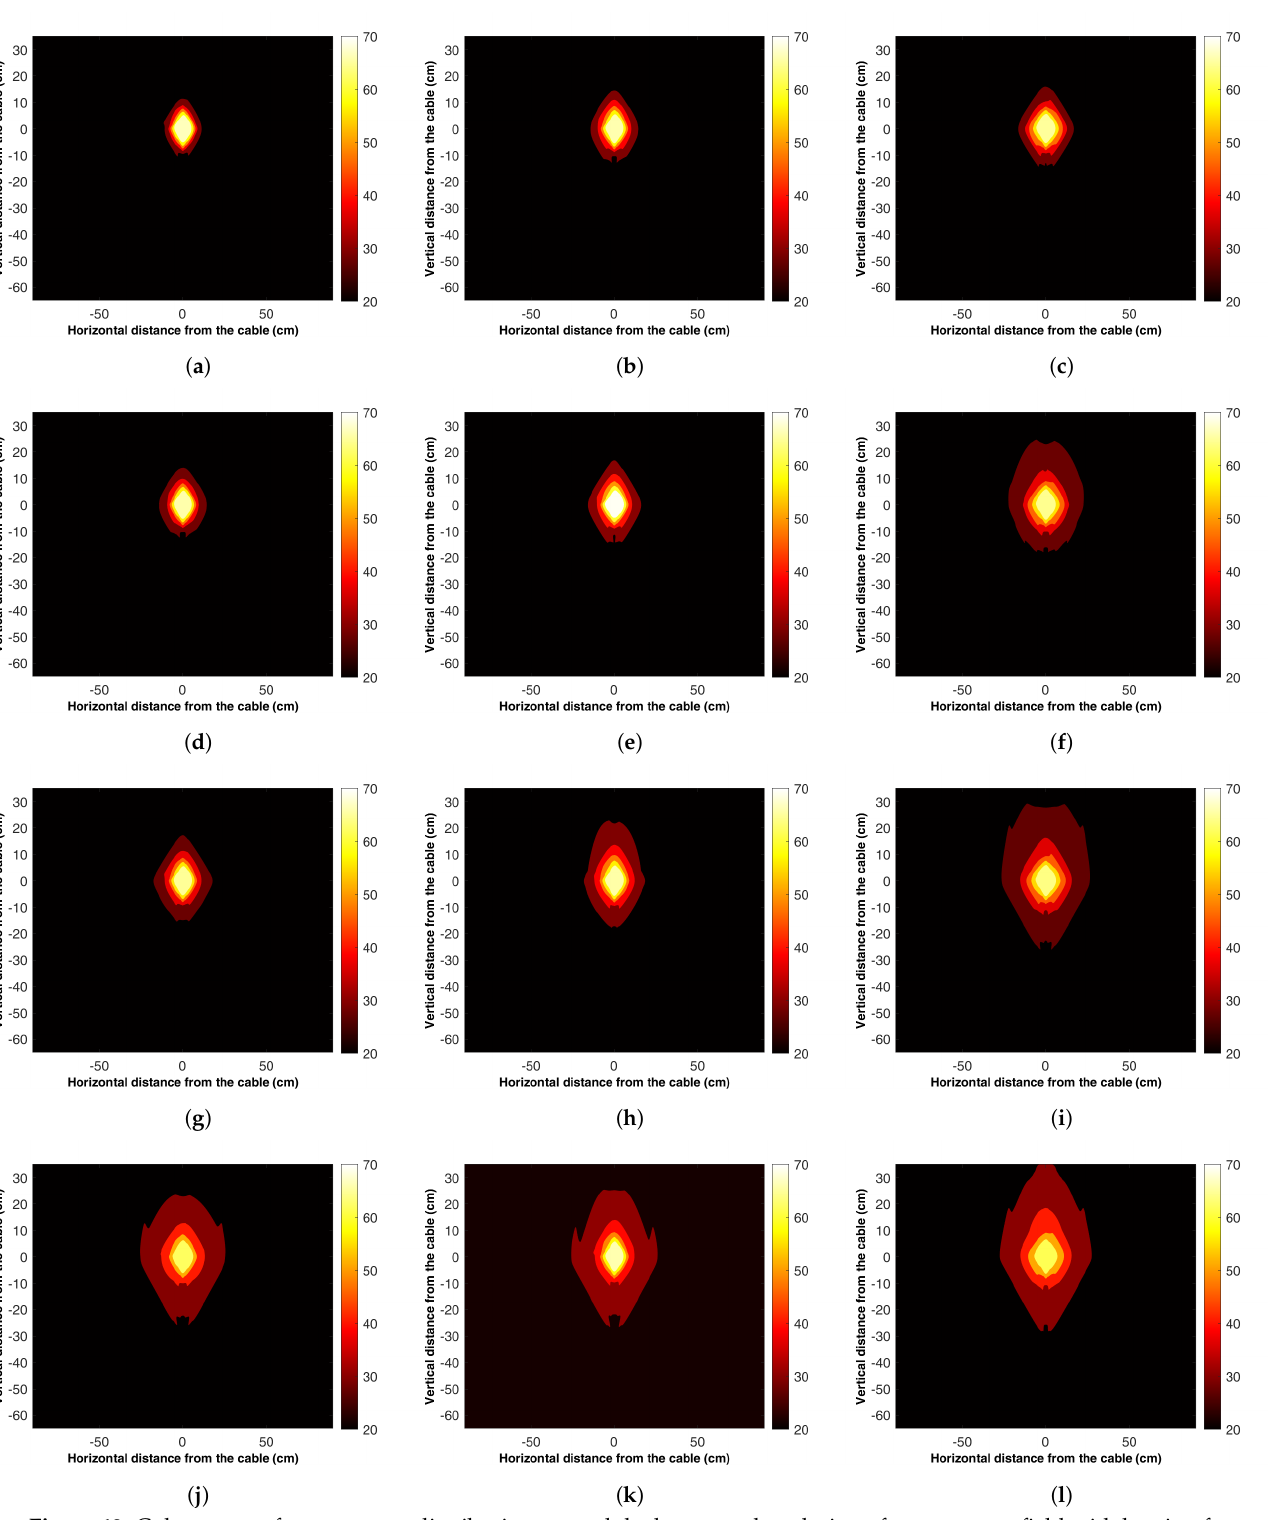
Figure 12. Colour map of temperature distribution around the heater and evolution of temperature field with heating for dry, unsaturated and saturated sand, after 3 hours ( a – c ), 6 hours ( d – f ), 12 hours ( g – i ), and 72 hours ( j – l